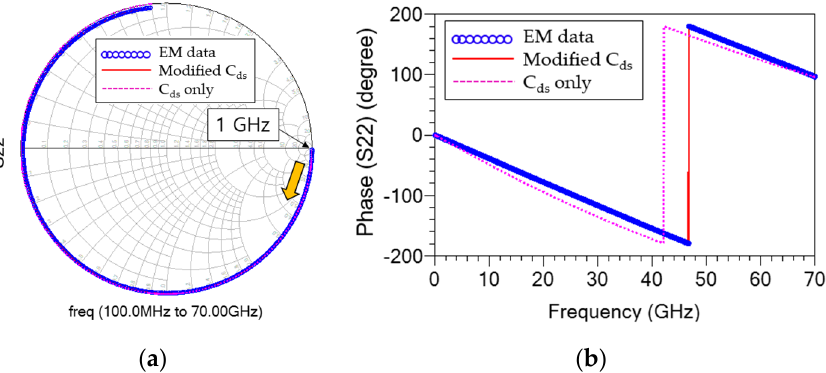
Figure 10. Comparison of the S-parameter of the extracted “modified C ds ” circuit with the EM simulated one through ( a ) Smith chart and ( b ) phase.